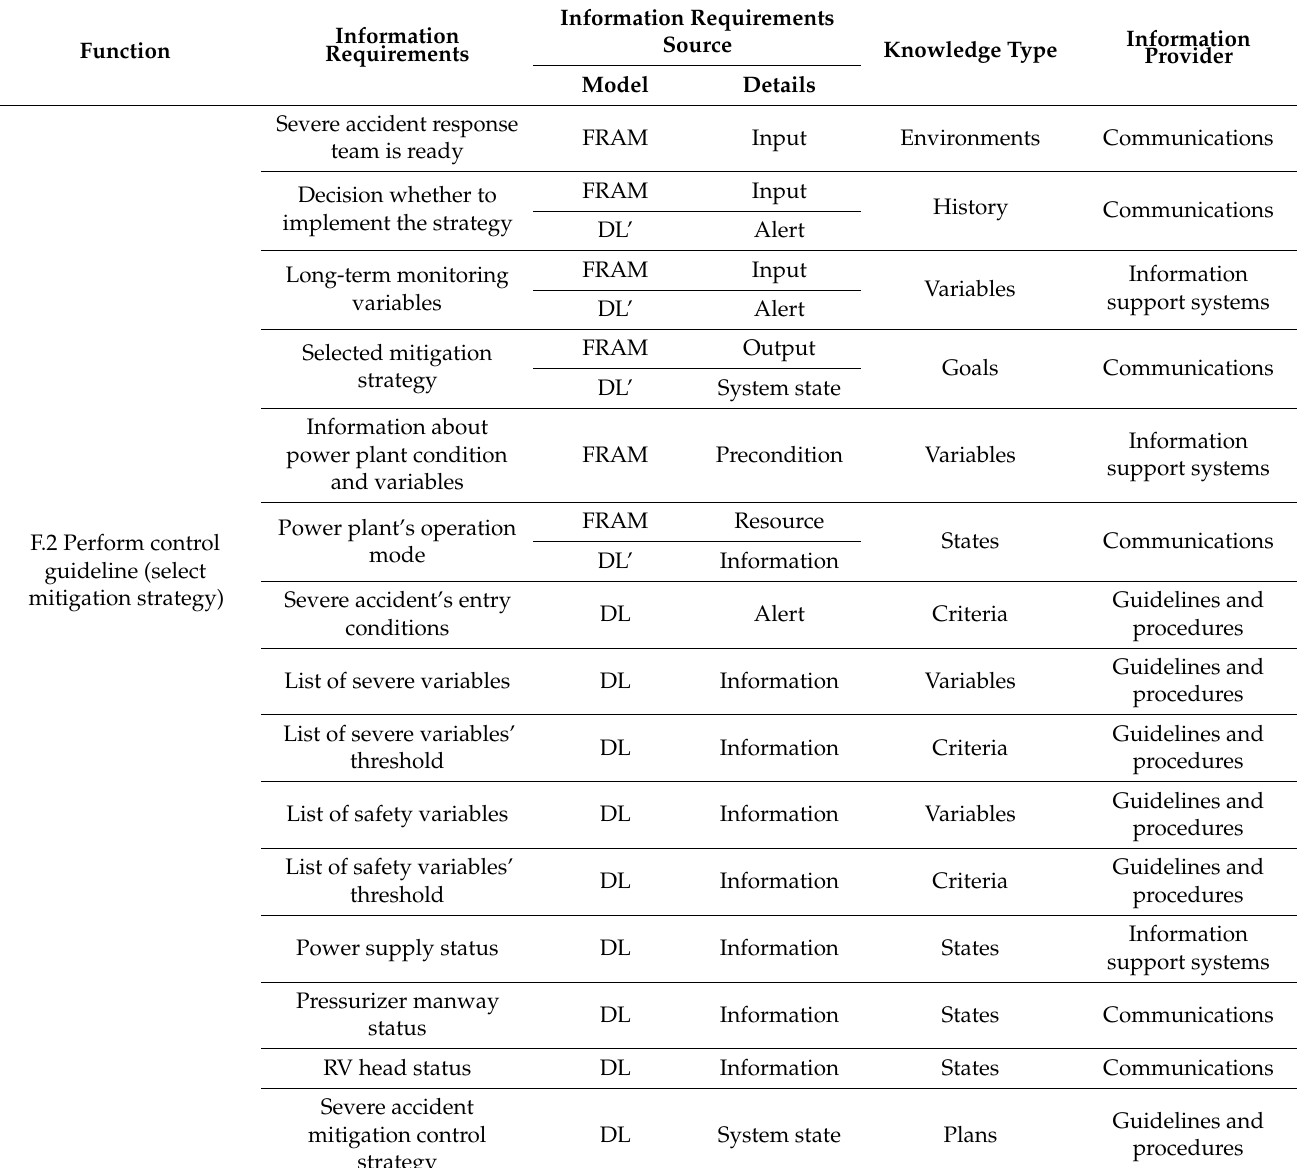
Table 4. Information requirements related to ‘F.2 Perform control guideline (select mitigation strat-